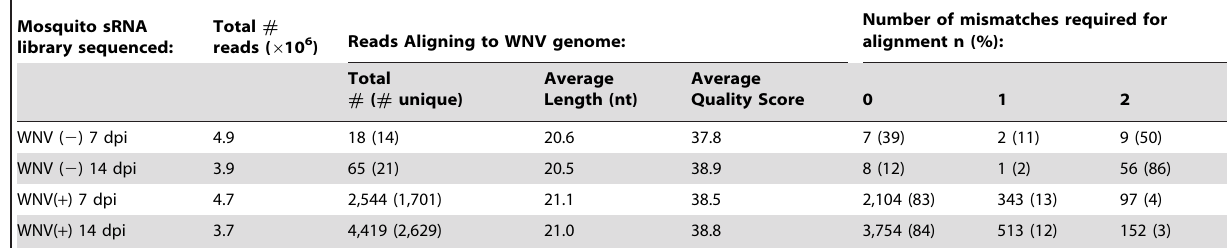
Table 1. Characteristics of small RNA libraries sequenced.